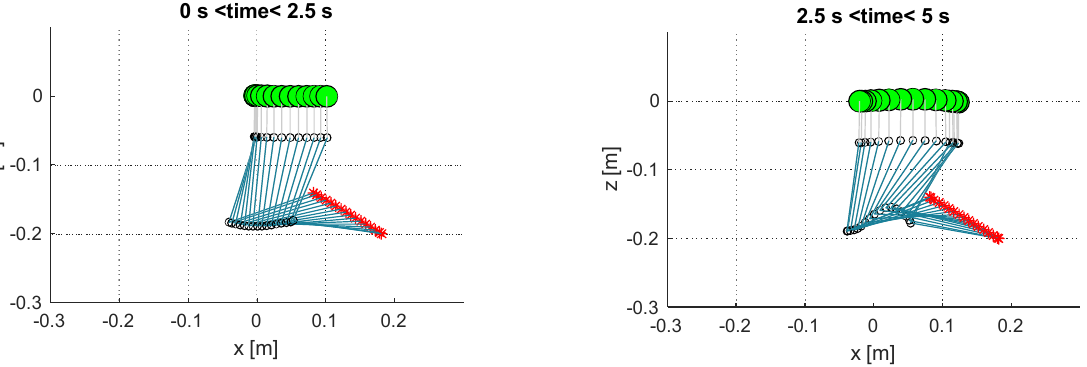
Figure 10. Stroboscopic trajectories for the first half ( left ) and second half ( right ) of the linear trajectory task for the 2-DOF UAM using the generalized Jacobian with external forces. The UAV base is the large green marker, joints are the black circles, links are the blue lines, and end-effector positions tracked are the red crosses.